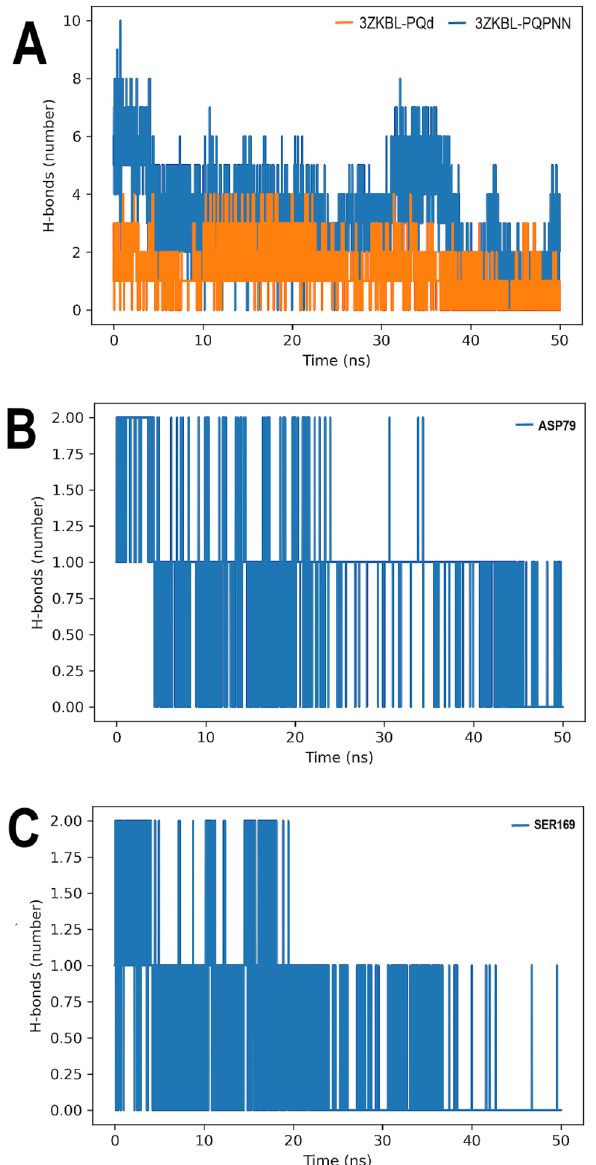
Figure 6. H-bonds analyses of 3ZKBL complexed with PQd, and PQPNN. ( A ) H-bonds in complexes. ( B ) Involvement of ASP79 of the 3ZKBL-PQPNN complex in H-bond formation during MD simulation. ( C ) Involvement of SER169 of the 3ZKBL-PQPNN complex in H-bond formation during MD simulation. All performed with